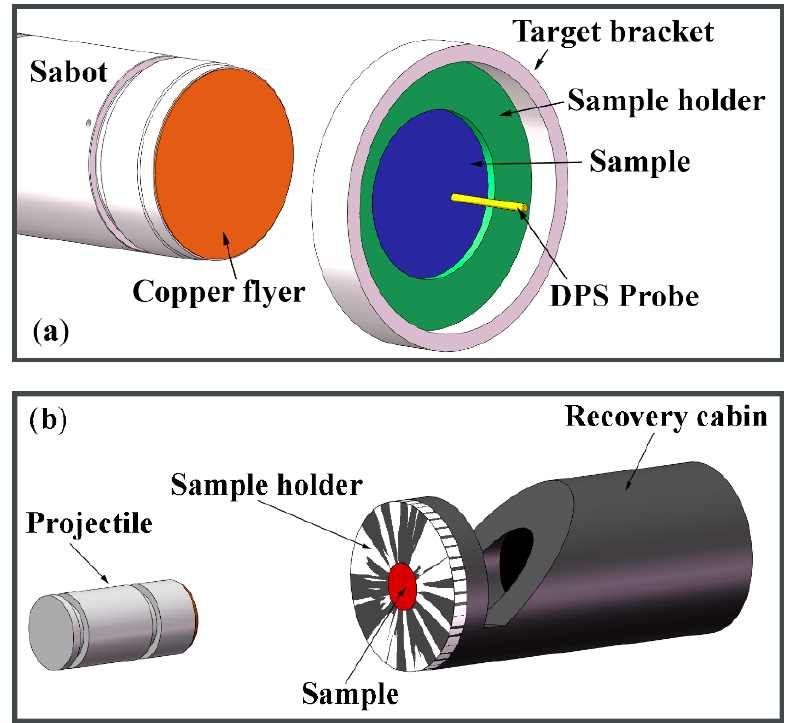
Figure 4. Experimental configurations for ( a ) free ‐ surface particle velocity measurements and ( b ) shock ‐ recovery characterizations. A Cu flyer is launched by a single ‐ stage gas gun to produce spall damage in TC4 samples. DPS is used to monitor the free ‐ surface velocity profile. A recovery cabin is used to capture the target sample for shock ‐ recovery characterizations.